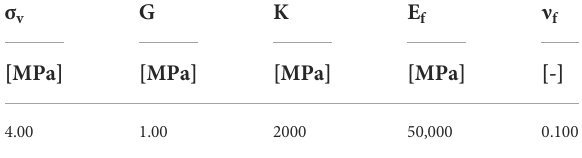
TABLE 2 Mechanical parameters set for the